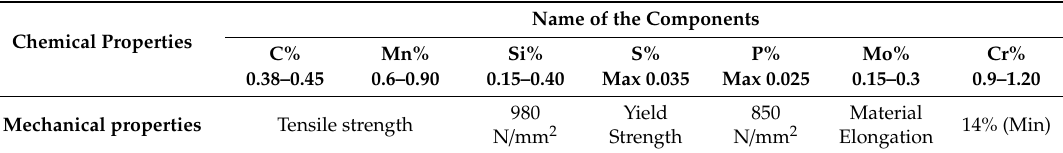
Table 1. The standard chemical composition of